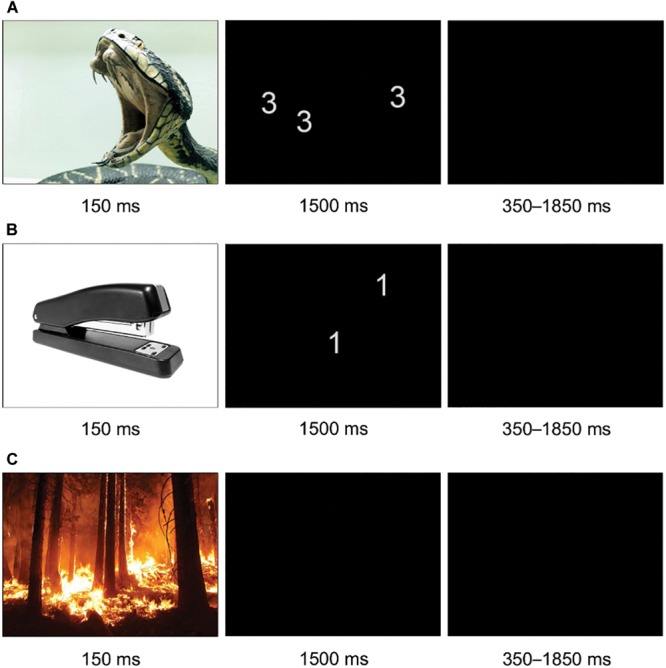
fMRI task design including three exemplary affective Stroop trials. (A) Negative-congruent trial; (B) neutral-incongruent trial; (C) negative-blank trial.